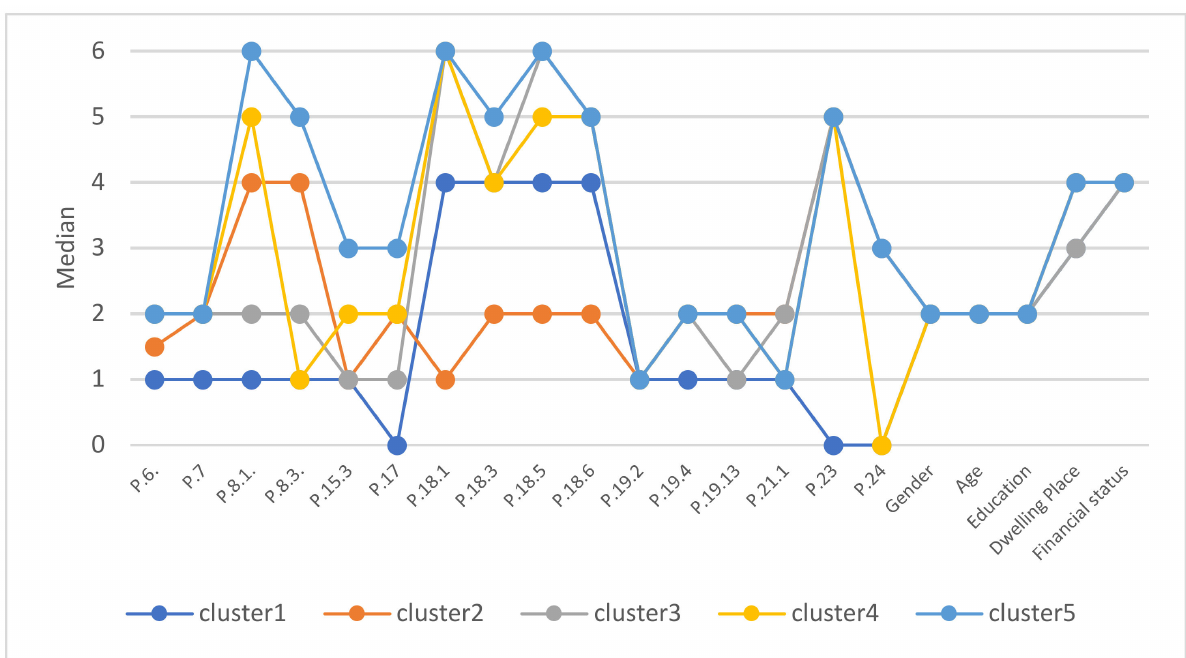
Figure 1. Medians of selected characteristics for observation in various clusters due to the behavior of consumers using catering